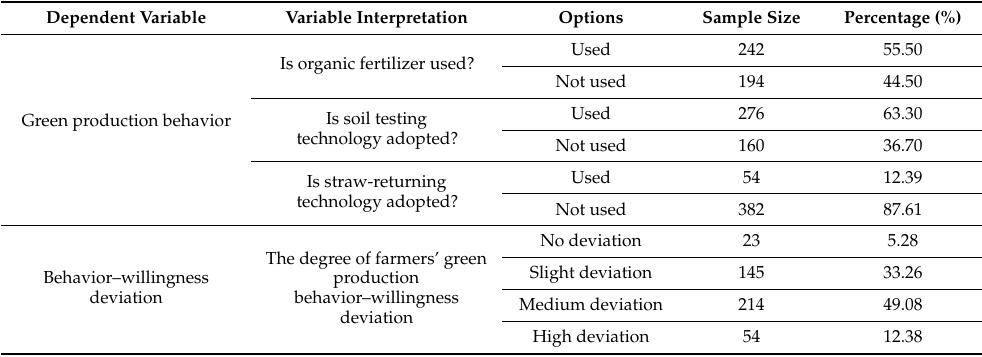
Table 2. The statistics of farmers’ green production behavior–willingness deviation.